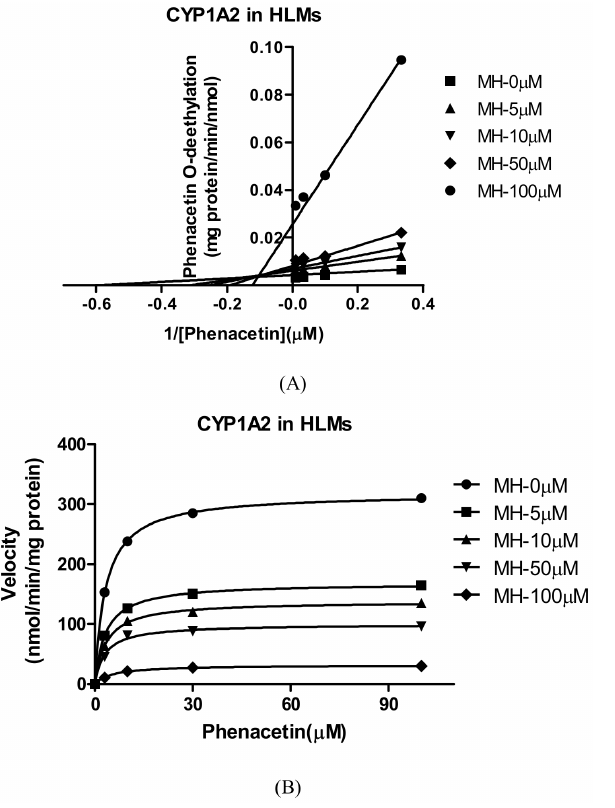
Figure 5. Double reciprocal (Lineweaver-Burk) plots for direct inhibition of phenacetin O-deethylation (A) and K i values. Note: The inhibition of CYP1A2 activity by MH can be best described as a mixed full inhibition mechanism by different concentrations of MH (0–100 m M) in HLM incubations (0.5 mg ? mL -1 protein). The data points are mean values of triplicate incubations. Non-linear regression analysis of the phenacetin O- deethylation versus substrate concentration was performed to obtain K i